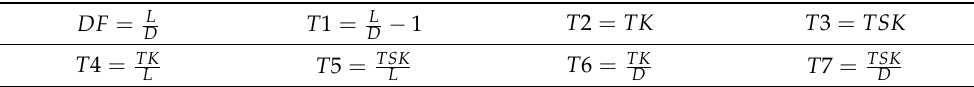
Table 2. Definition of eight common local tortuosity indices